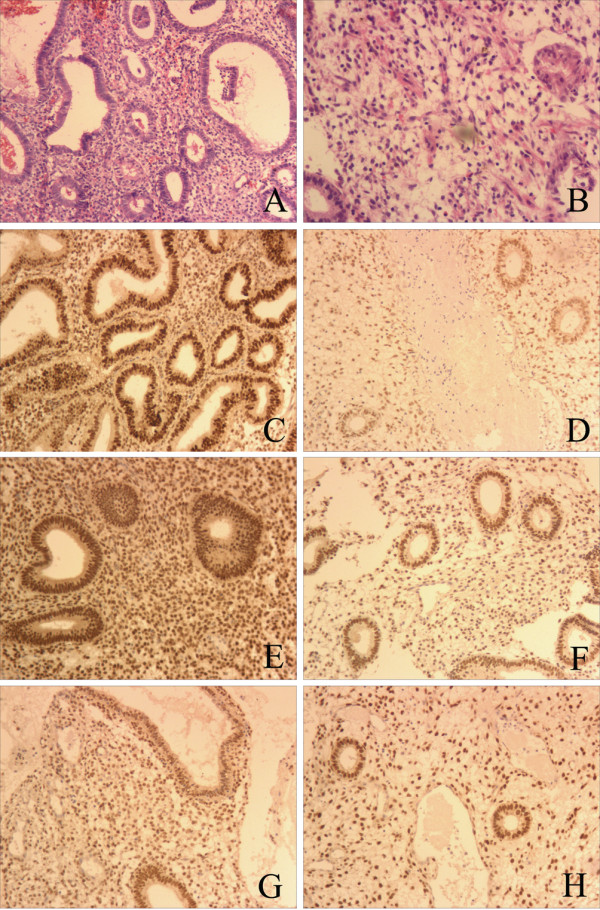
Endometrial pathology and survivin, ER, and PR expression before and 6 to 7 months after REA treatment in DUB patients with complex endometrial hyperplasia. (A) Before REA, the endometrium showed complex hyperplasia, ‘back to back’ glandular hyperplasia, leather bag shape glandular enlargement. (B) Six to seven months after REA, glandular tissue became fibrous tissue with scarce glands and blood vessels in endometrial curettage. (C) Before REA, the expression of survivin (strong positive). (D) Six months after REA, the expression of surviving showed weak positive. (E) Before REA, the expression of ER (strong positive). (F) Six months after REA, the expression of ER showed weak positive. (G) Before REA, the expression of PR (strong positive). (H) Six months after REA, the expression of PR showed weak positive. DUB, dysfunctional uterine bleeding; ER, Estrogen receptors; PR, Progesterone receptor; REA, Radiofrequency endometrial ablation.